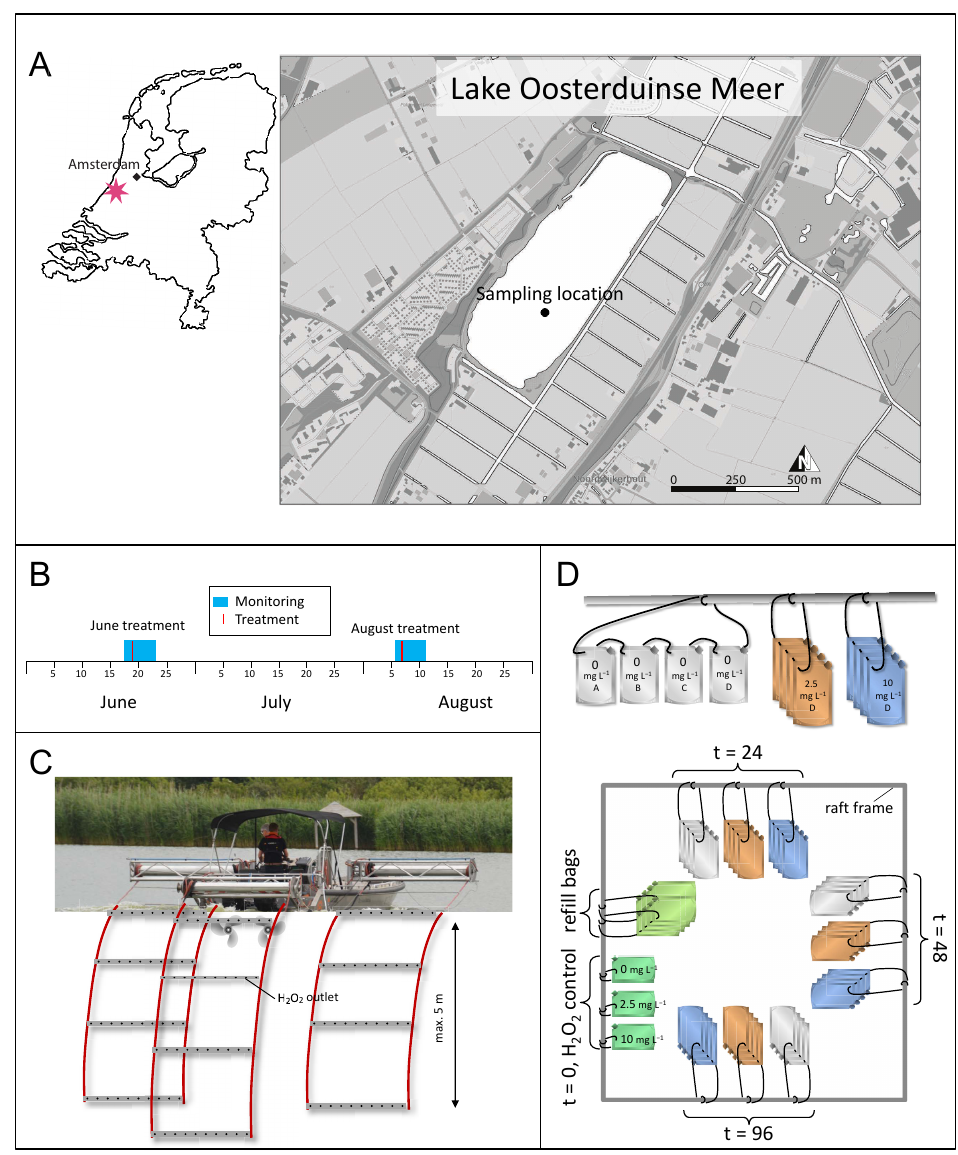
Figure 1. Location of the lake and experimental design. ( A ) The location of lake Oosterduinse Meer in The Netherlands and the sampling location in the lake. In June and August ( B ), H 2 O 2 was carefully added to the top 5 m of the lake with the help of a specialized boat ( C ). Both lake treatments were accompanied by incubation experiments ( D ). The incubation bags were attached to a raft which was anchored at the sampling location in the lake. All the incubation bags were filled with surface lake water at t = − 24 h and attached to the raft in groups of four replicate incubation bags per treatment condition (control, 2.5 and 10 mg L − 1 H 2 O 2 ) and sampling time point (t = 24 h, t = 48 h and t = 96 h). At the same time as the lake was treated with H 2 O 2 , the incubation bags of all the treatment conditions and sampling time points received 0 mg L − 1 H 2 O 2 (Milli-Q) in the control incubations (gray) and 2.5 mg L − 1 H 2 O 2 (orange) and 10 mg L − 1 H 2 O 2 (blue) in the other experimental treatments. The three incubation bags at t = 0 h (dark green) were treated with either 0, 2.5 or 10 mg L − 1 H 2 O 2 and immediately brought to shore and sampled 10 min after the treatment for H 2 O 2 concentration determination as well as phytoplankton analysis. At each consecutive time point, the corresponding incubation bags of the three treatments (gray, orange and blue) were taken out of the water and brought to shore for analysis. Each mesocosm bag served as a biological replicate and was sampled only